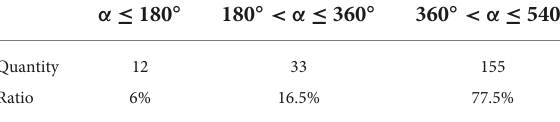
TABLE 3 Rotation angle before tomato separation.